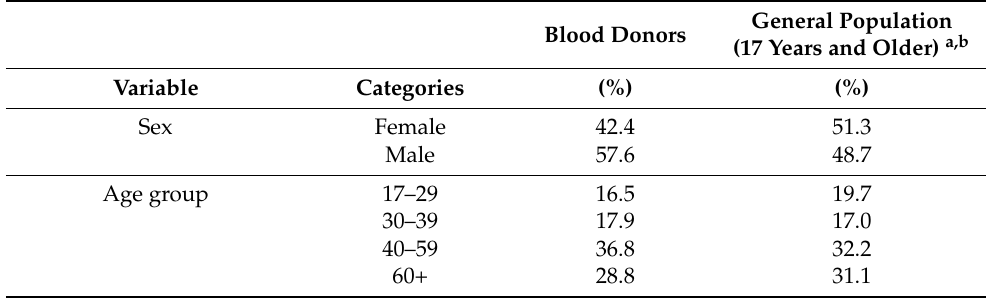
Table A2. Demographic data (from donors donating between 1 September 2021 and 30 June